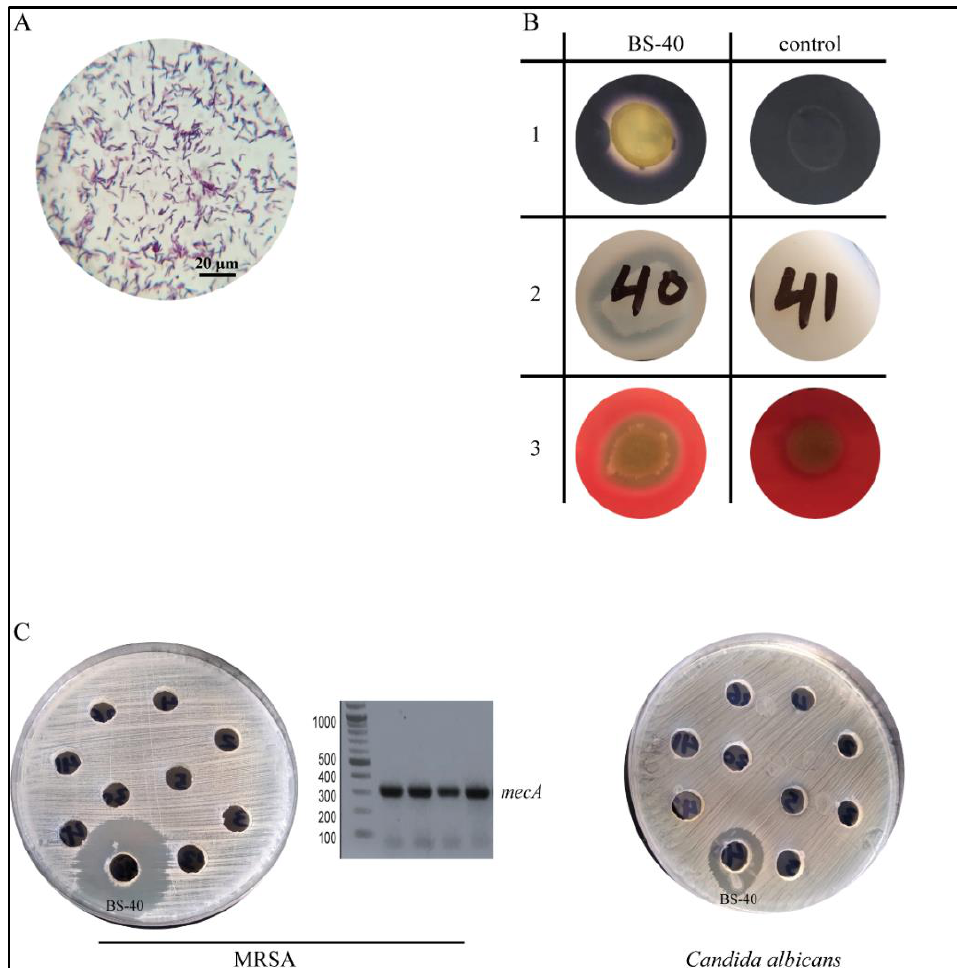
Figure 1. Screening for antimicrobial activity was carried out by well diffusion method and biochemical characterization of the antibiotic producing strains. ( A ) Gram stain film of antibiotic producing strain isolate BS-40, microscopic examination indicates Gram-positive rods (scale bar 20 µm). ( B ) Biochemical examination of isolate BS-40 for different enzymatic activities, such as amylolytic activity (1), proteolytic activity (2), and hemolytic activity (3); biochemical tests were performed according to standard procedures (see Materials and Methods section) and a control strain (non-amylolytic, non-proteolytic, and non-hemolytic) was plated in parallel for comparison. ( C ) Soil isolated bacterial strains were cultured, then supernatants were filtered, and each supernatant was filled into wells against the indicator strains (in this figure antimicrobial activity against MRSA clinical isolates and Candida albicans ) and the zone of inhibition was measured in mm after 48 h of incubation (MRSA clinical isolates were identified by antibiotic sensitivity and existence of mecA gene tested by